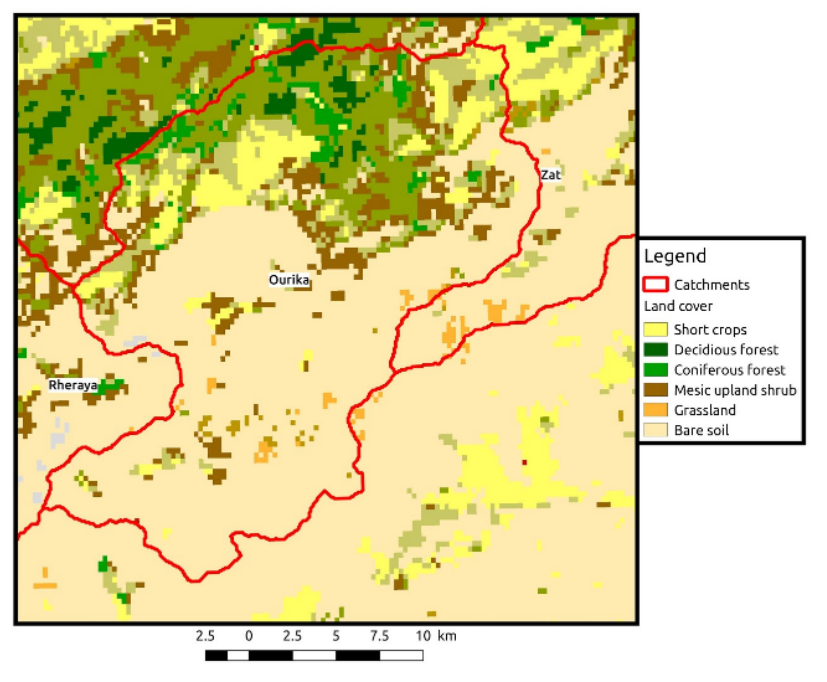
Figure 3. Ourika land cover